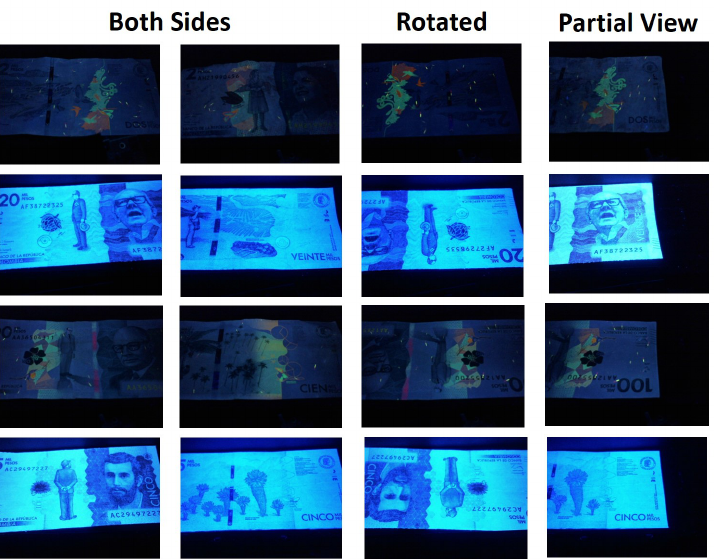
Figure 6. Examples of images of Colombian banknotes. Available at [28] under license CC-BY-4.0.